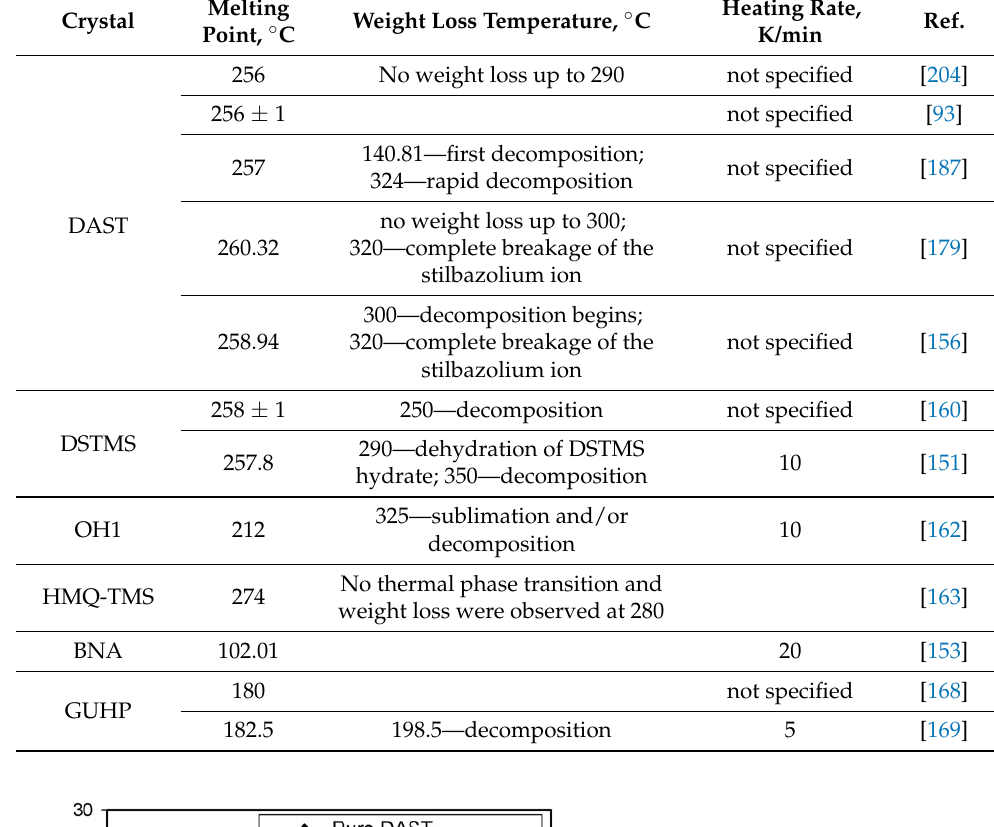
Table 6. Melting point and decomposition temperature.